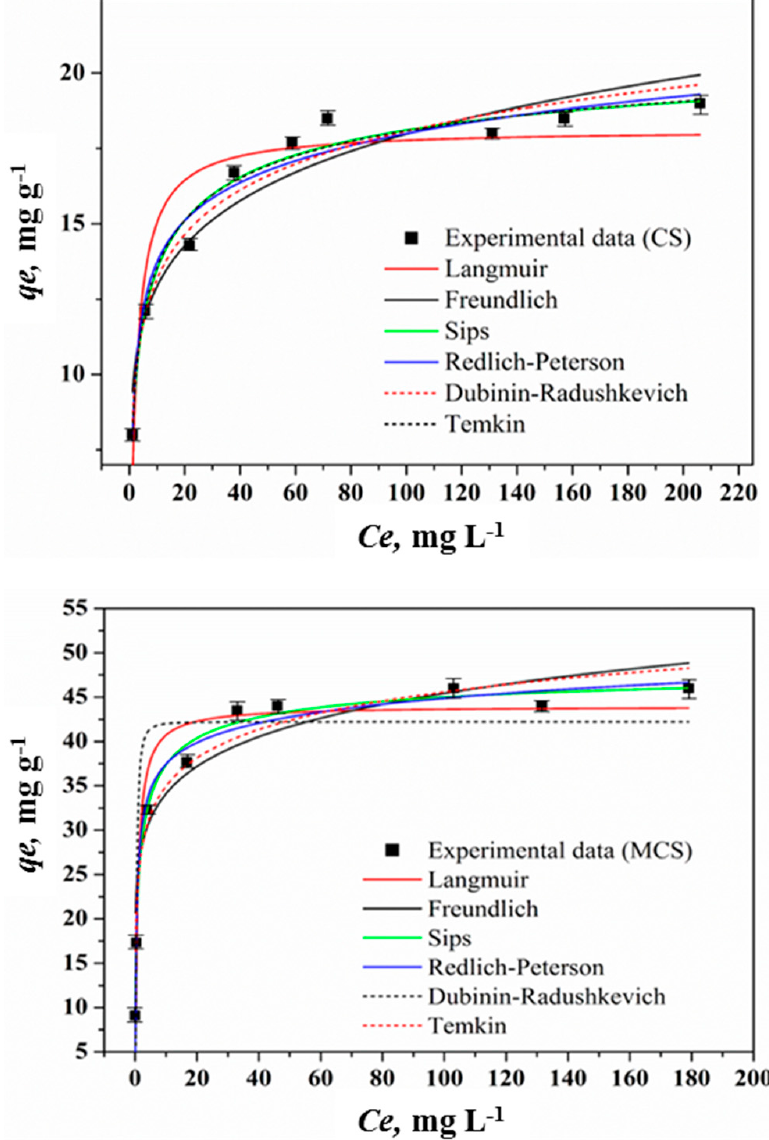
Figure 5. Isotherm models of Cd 2+ adsorption on to CS and MCS.